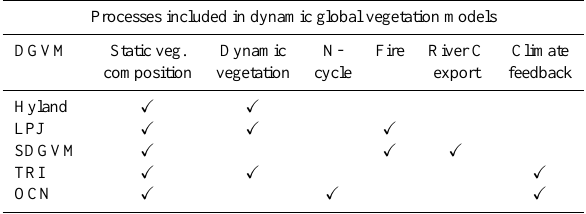
Table 8. Exports of wood and wood